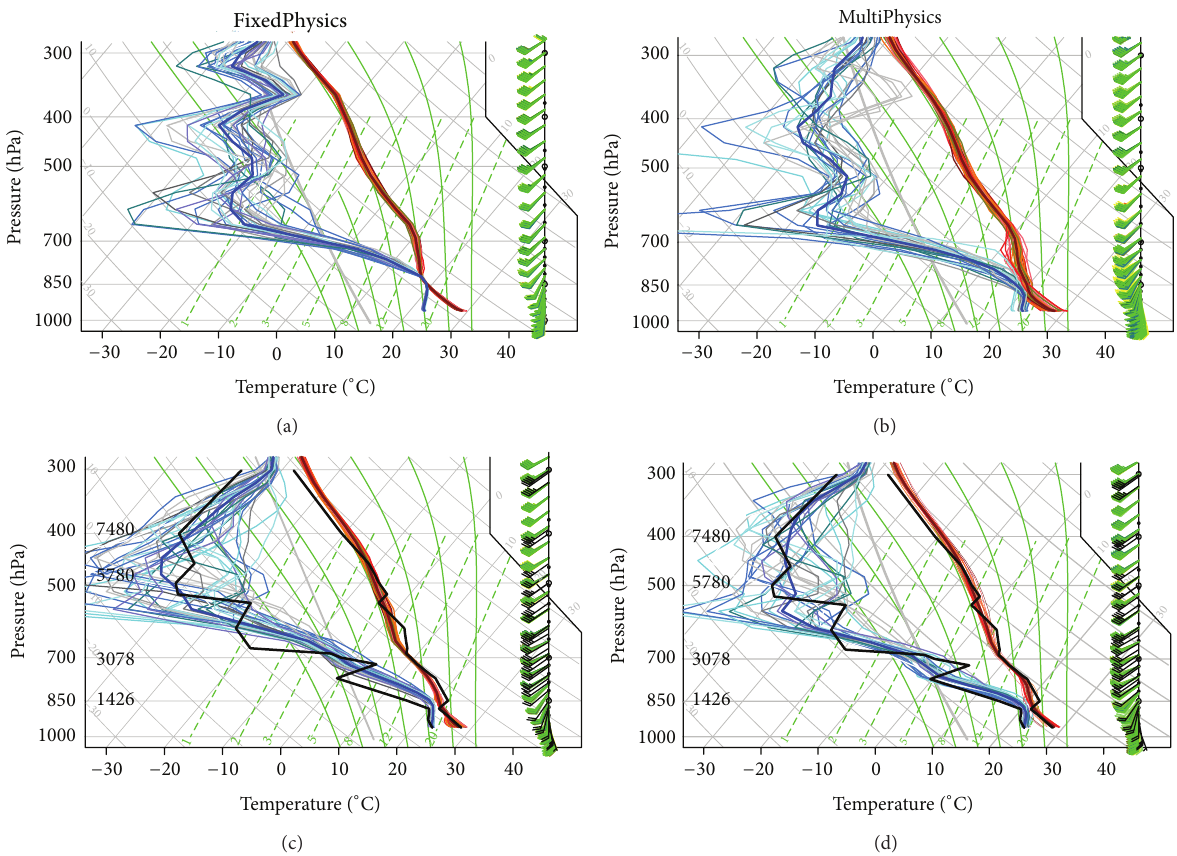
Figure 2: Environmental soundings from the 36-member ensembles with temperature (thin red lines) and dewpoint temperature (thin blue lines)at2100UTCMay8((a)and(b))and0000UTCMay9,2003((c)and(d))fromtheOklahomaCity(KOKC)stationfromtheFixedPhysics and MultiPhysics mesoscale ensemble data assimilation systems. Overlaid are the ensemble mean (thick lines) and radiosonde observations (black) at 00 UTC May 9, 2003 ((c) and